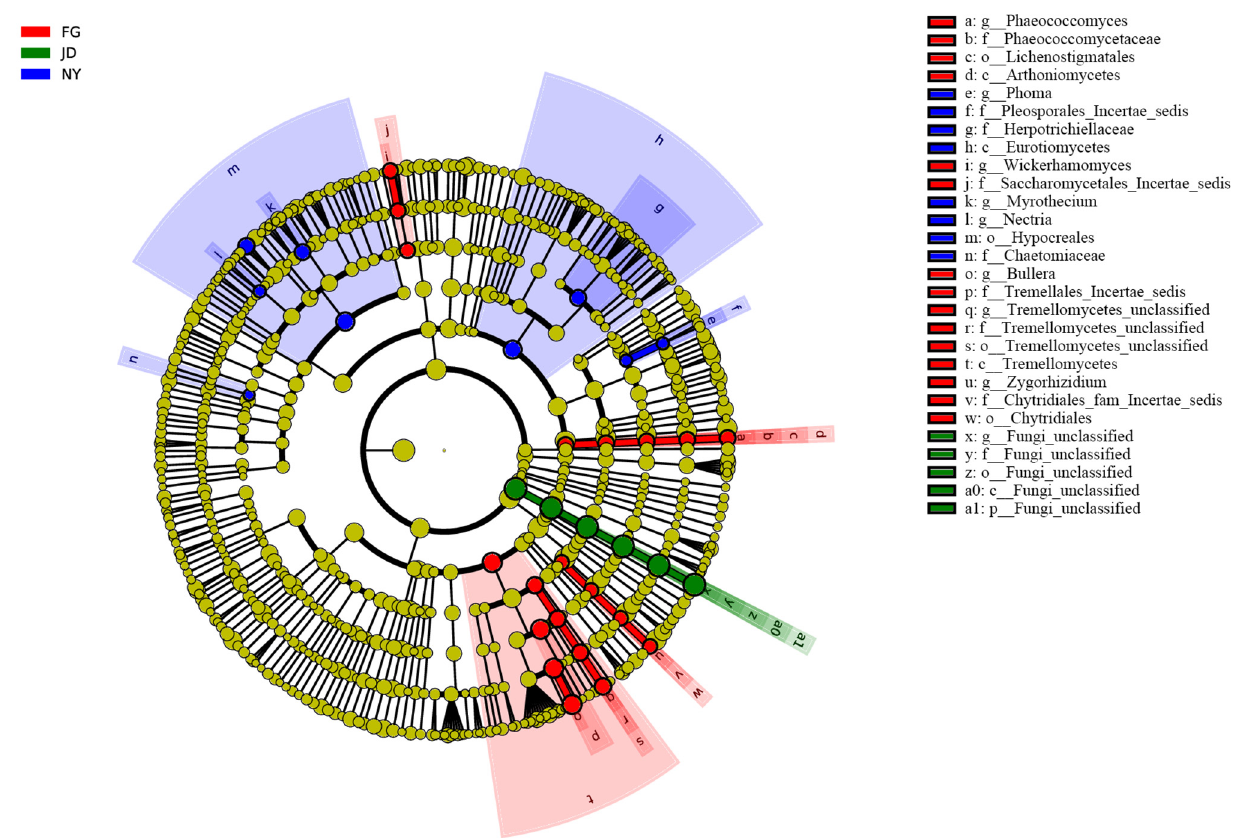
Figure 6. LEfSe showing the significant differences at different fungal taxonomic levels among the CT, SC, and MR treatments. Different colored dots represent the taxa with significant differences among all treatments. The inner to outer circles represent taxa from phylum to species.